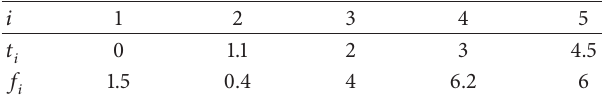
Table 5: 2D data set lying above the line 𝑦 = 0.06𝑥 + 0.02 .